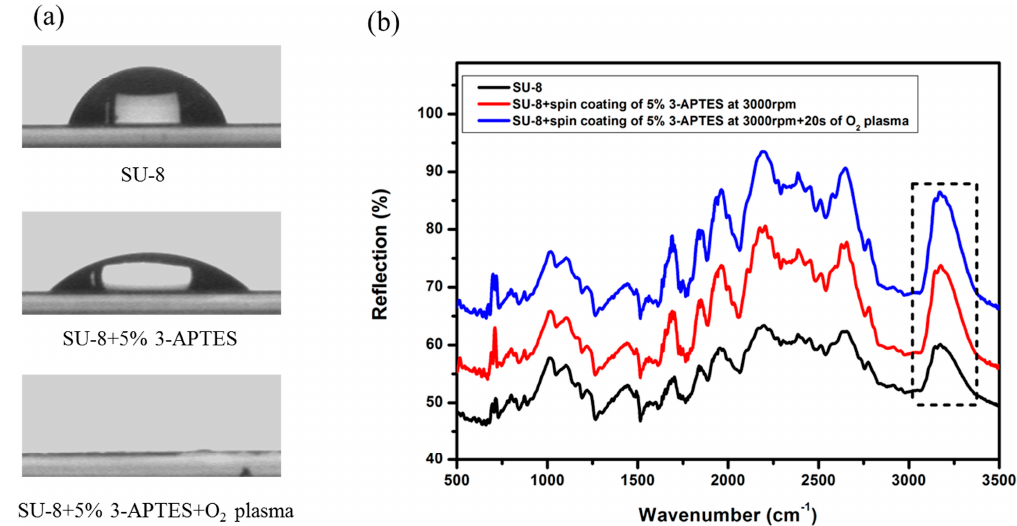
Figure 4. The contact angle varies after surface modification ( a ) and FTIR reflection spectra of SU-8 before and after treatment with APTES and the peak assignment ( b ). Peaks at 3172 cm − 1 contribute to -OH group at different processing stages.